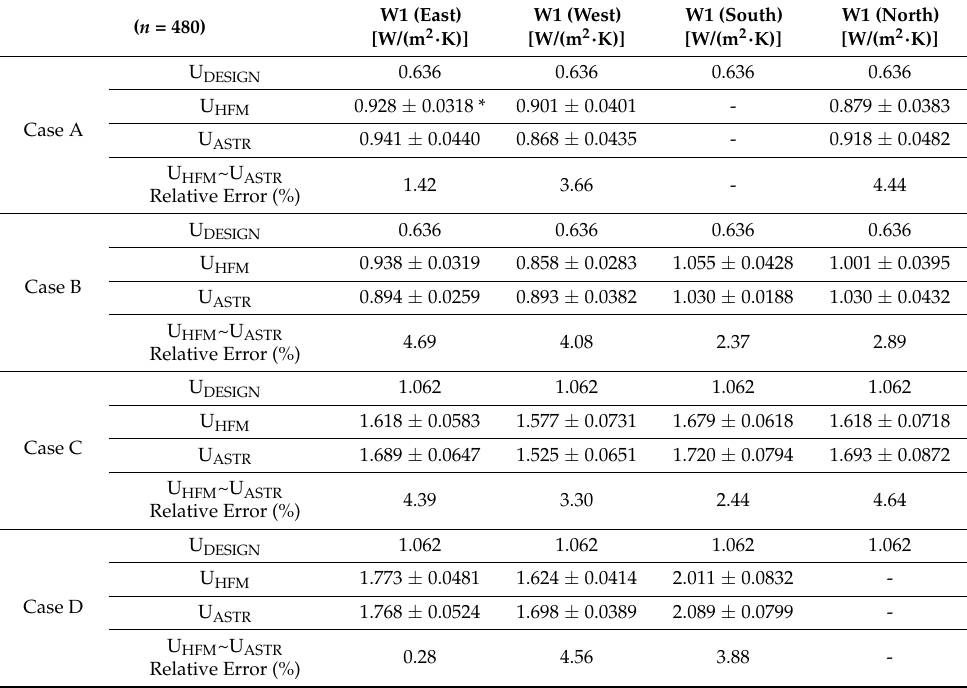
Table 4. Results of wall U-value measurements prior to